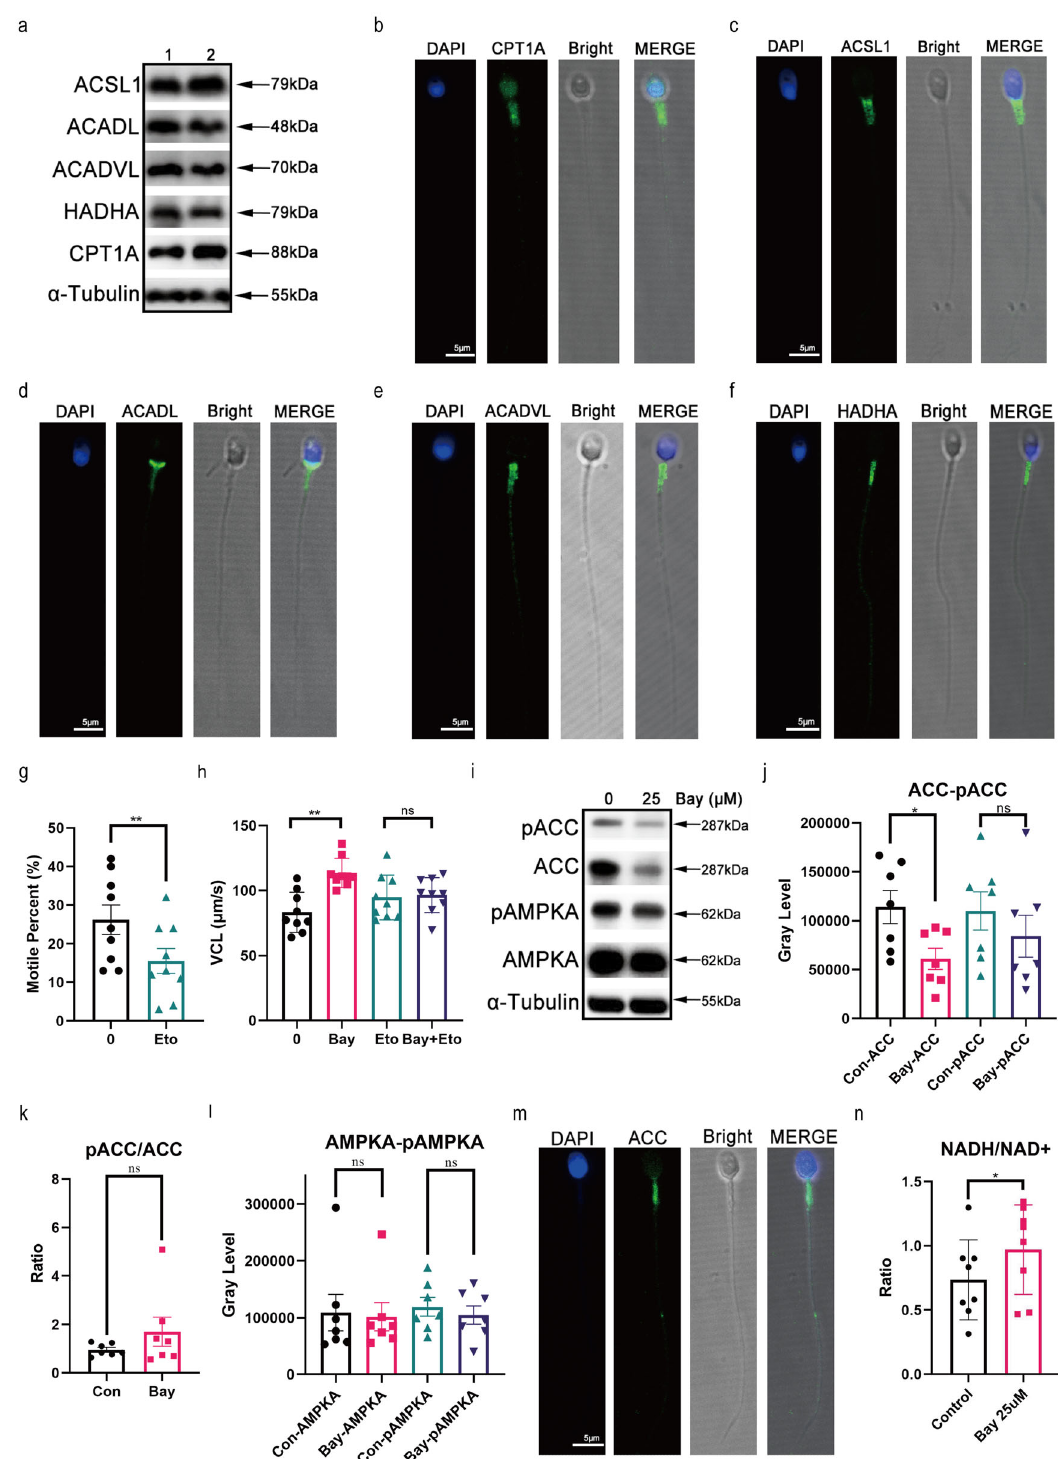
(IKBA cKO) model based on the CRISPR-Cas9 and Cre-/LoxP technologies ( Nfkbia f/f ; Stra8-Cre ) (Supplementary Fig. 1a, b). Genotyping PCR was performed to assess the genotype of mice (Supplementary Fig. 1c, d). Western blotting and immuno- fl uorescence analysis indicated the deletion of IKBA in ( Nfkbia f/f ; Stra8-Cre + ) mouse (IKBA -/- ) sperm (Fig. 7a, b). Motility parameters showed no statistically signi fi cant difference between IKBA -/- and control sperm (Supplementary Fig. 1e).